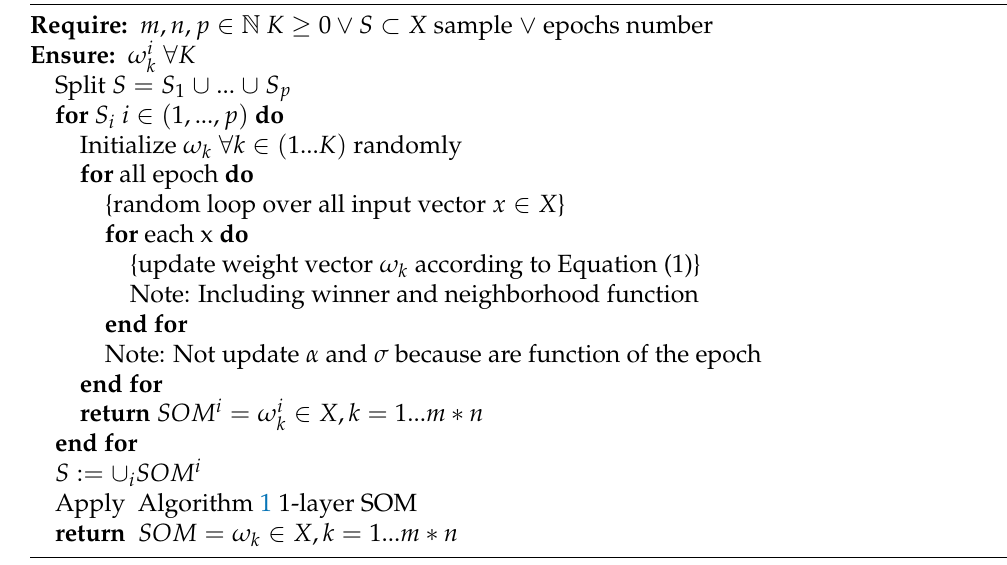
Algorithm 2 Two-layer SOM